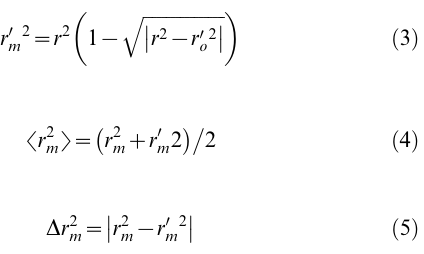
Table 3. Optimal runtime parameters for the SVM model.